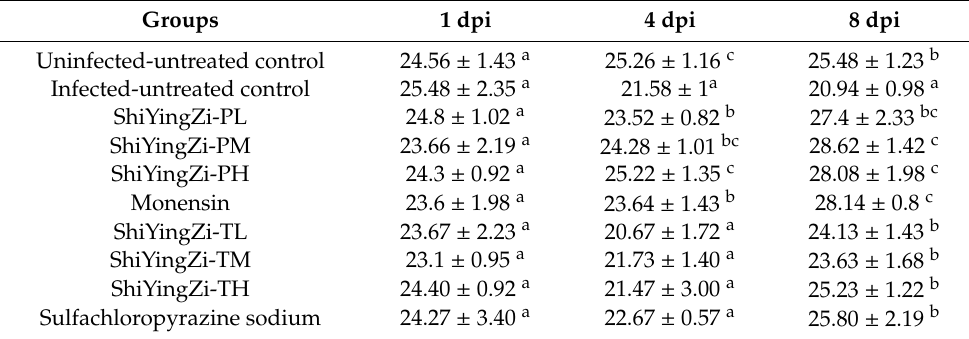
Table 5. Total protein content (g / L).